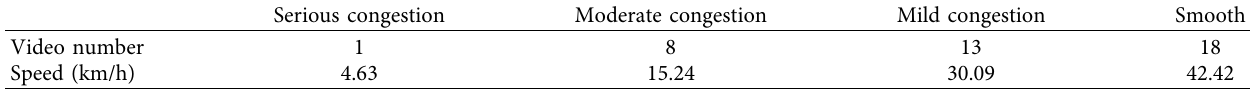
Table 1: Trafc fow parameters at diferent congestion levels.